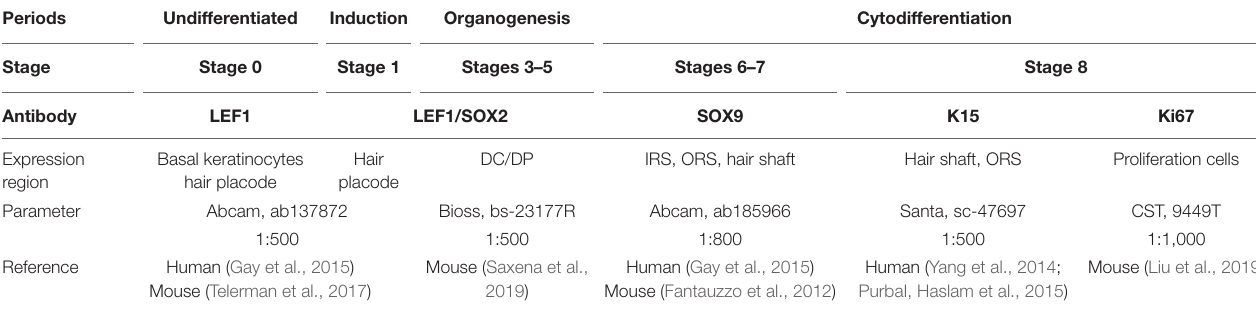
TABLE 1 | The information of five antibodies in this